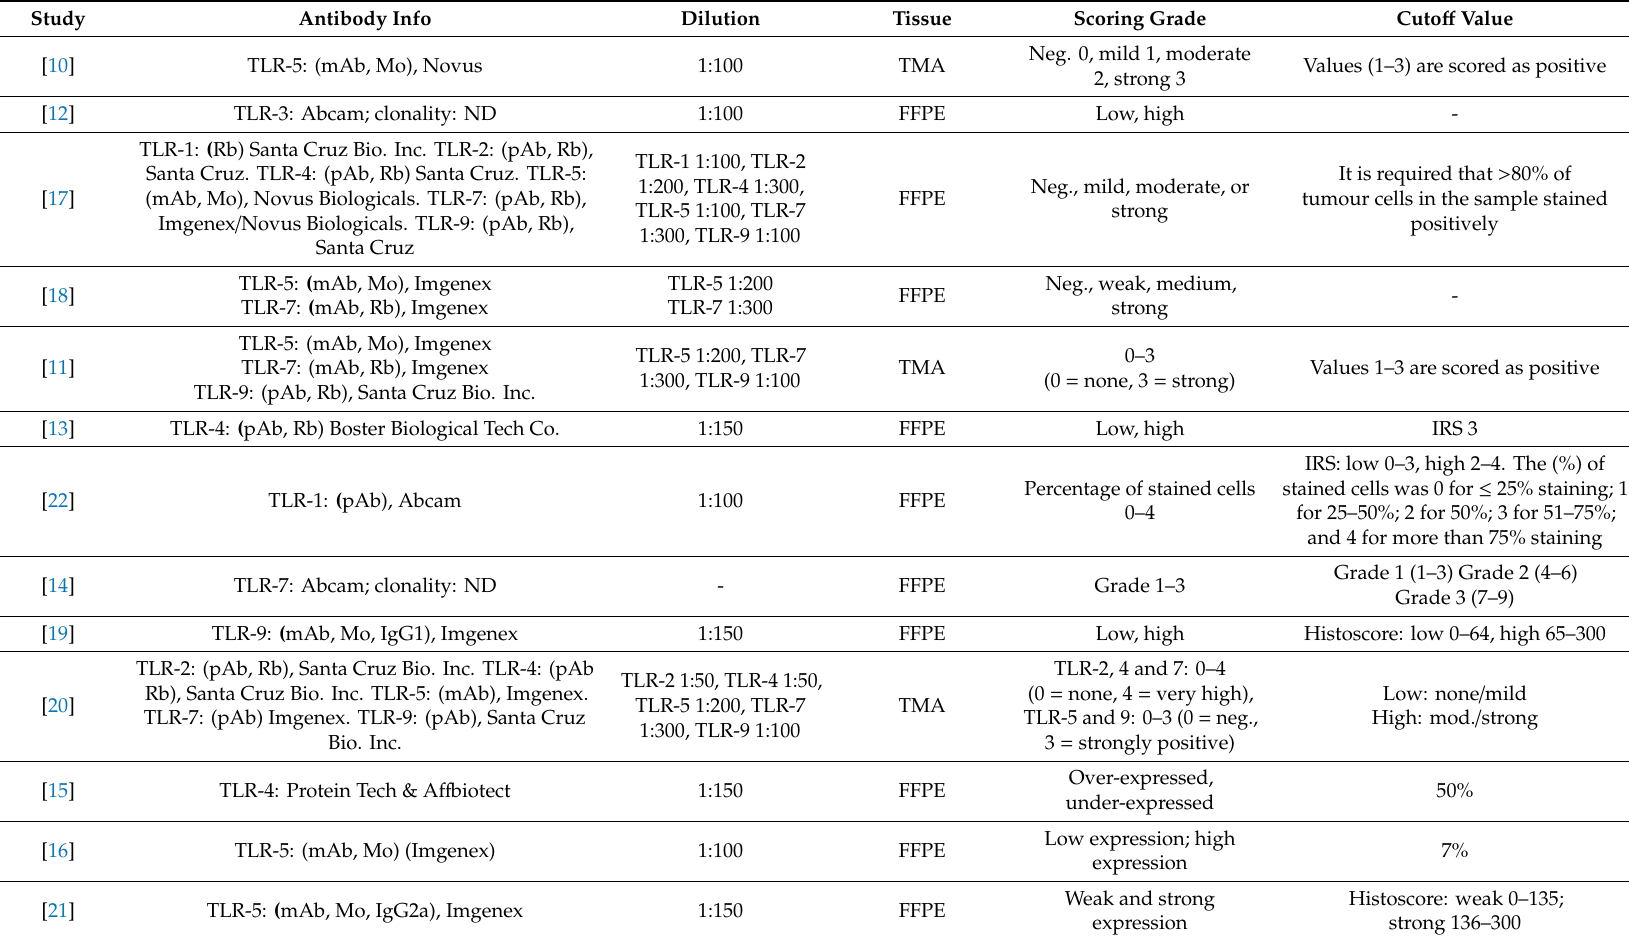
Table 2. Summary of the staining and evaluation